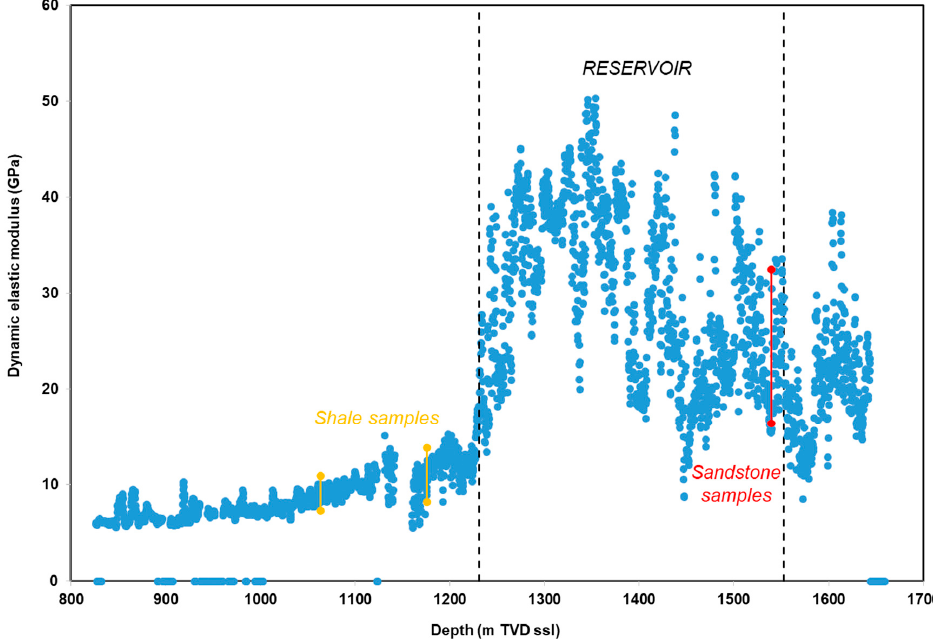
Figure 6. Lab test results: static elastic moduli values in relation to confined pressure.